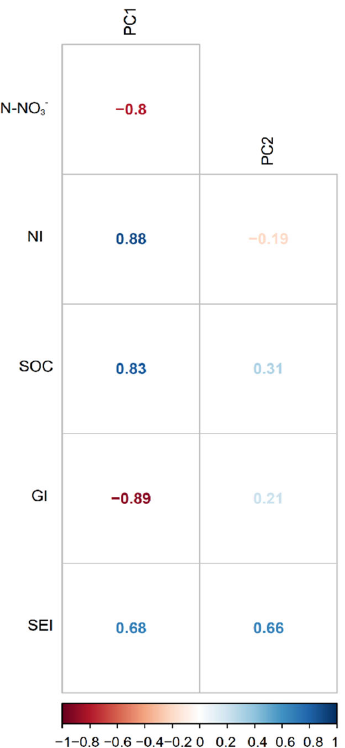
Figure 8. Pearson’s correlation matrix between indicators and PCs.